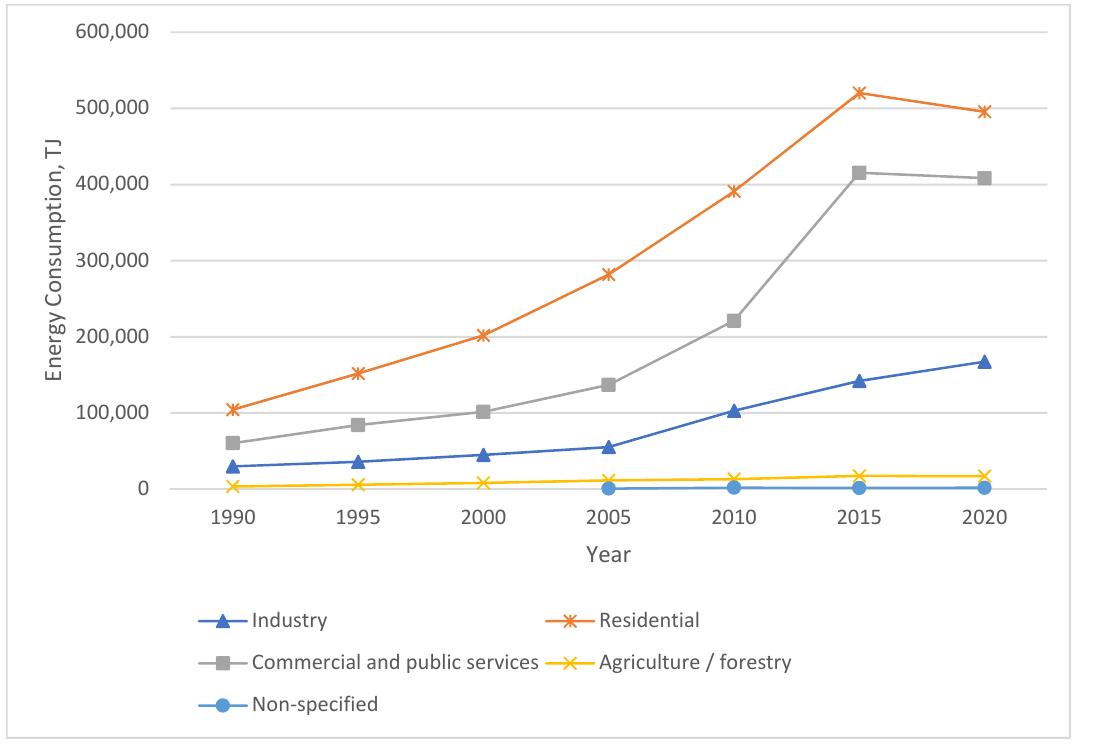
Figure 5. Electricity end-use consumption by sector between 1990–2020 [3].